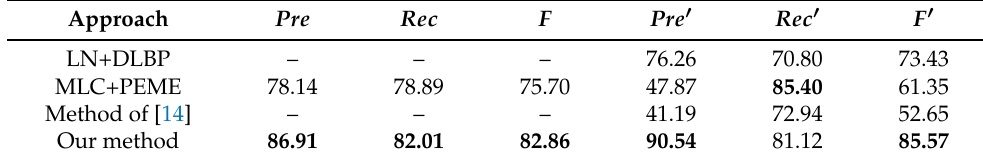
Table 1. Comparison between our method and the other methods for the Type-I RSDDs data set. Approach Pre